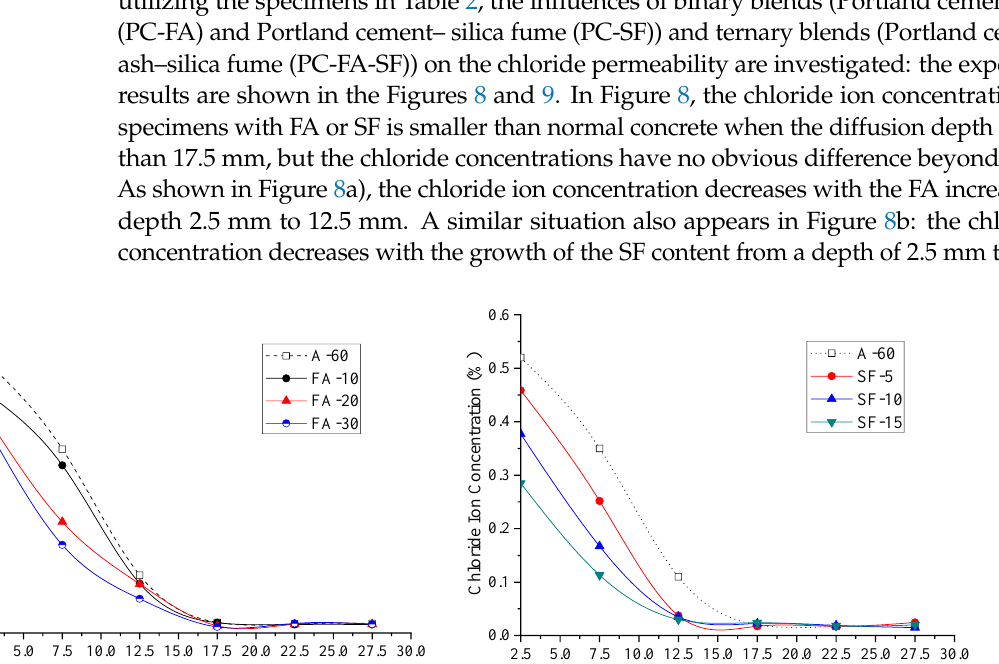
Figure 7. Compressive strength of the specimens in Jerath and Hanson’s test.